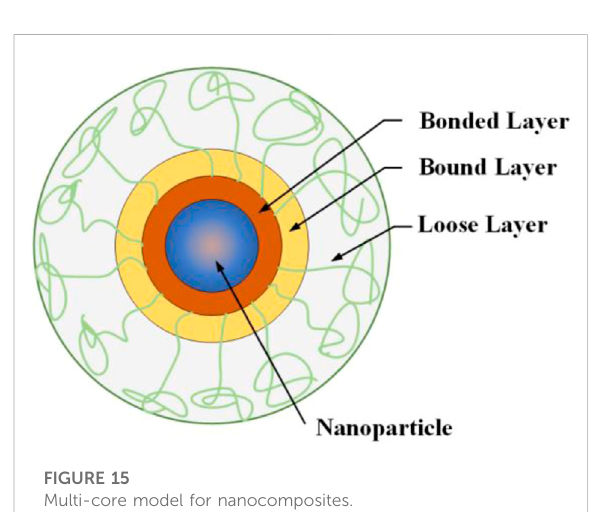
FIGURE 16 Effect of temperature on the hopping distance of charge